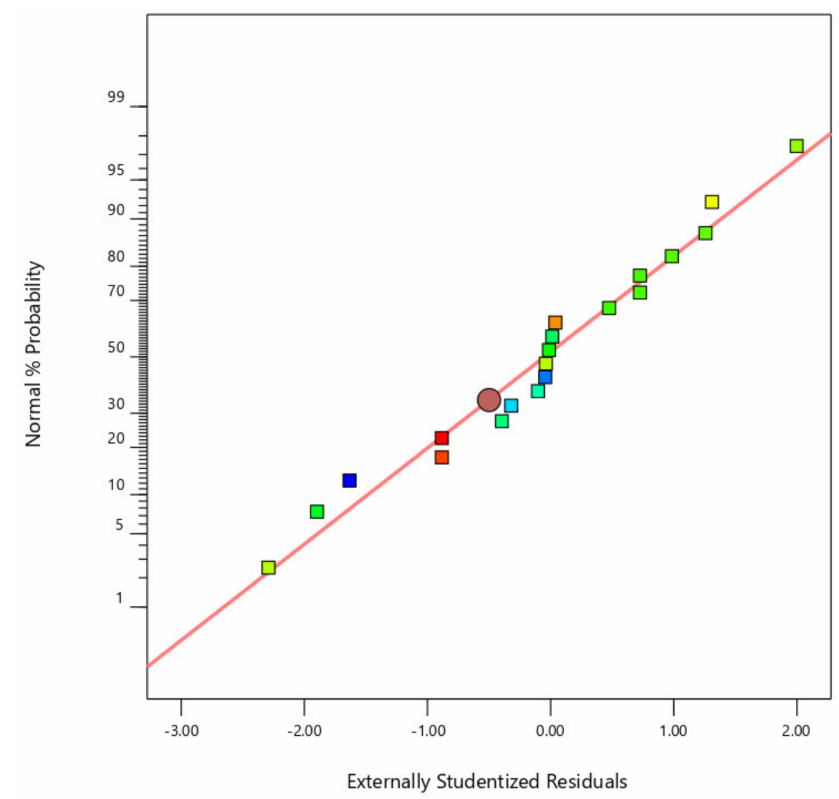
Figure 2. Normal plot of residuals for coating thickness (C t